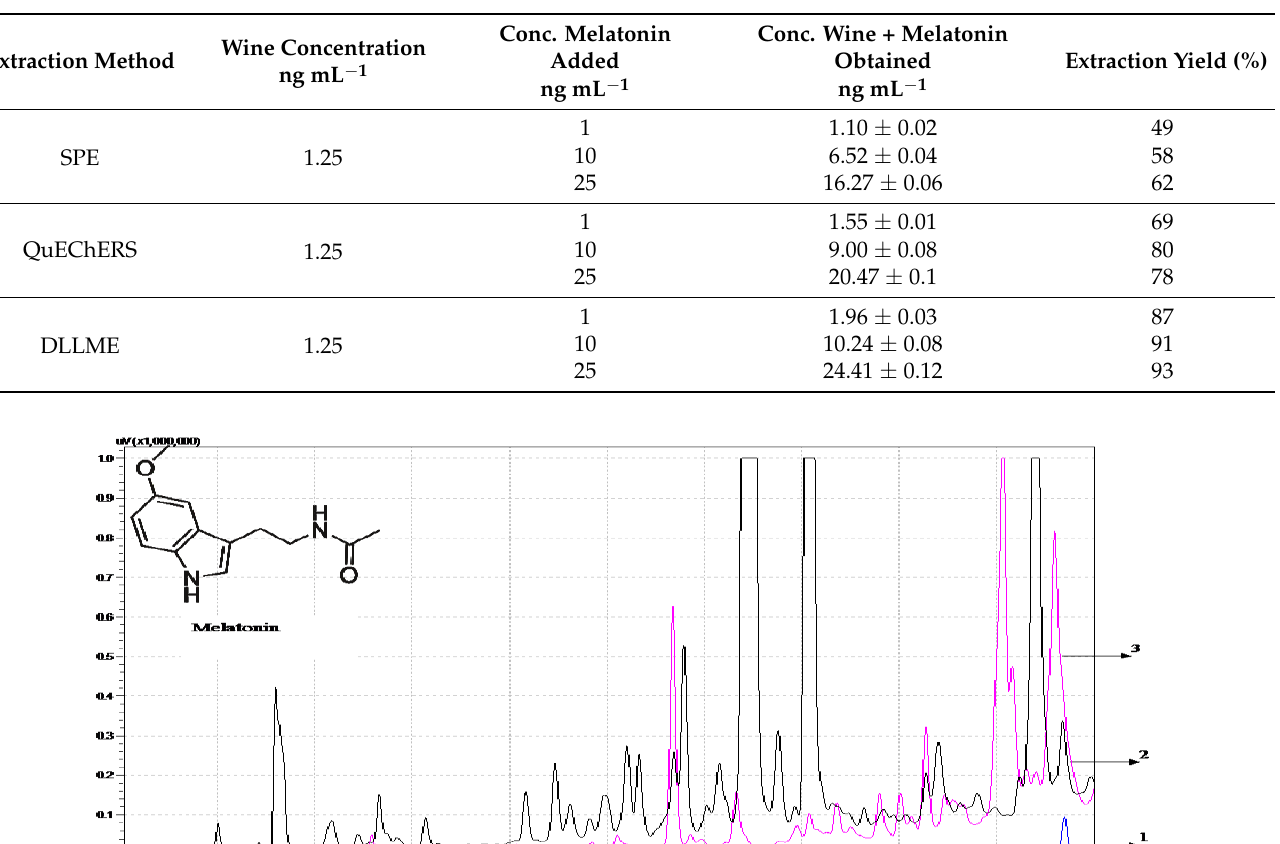
Table 4. Extraction yields using different extraction approaches for the analysis of melatonin from wine.